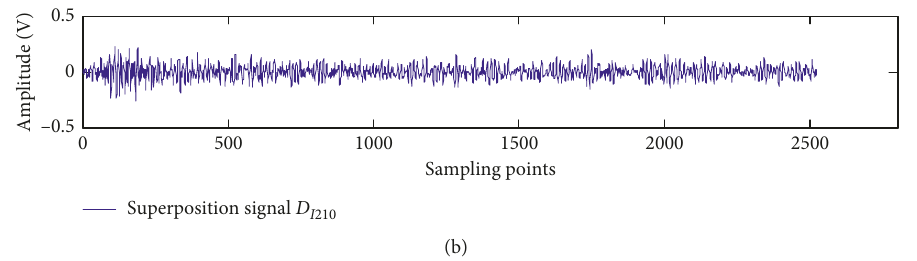
Figure 21: Two superimposed sections of the connecting rod bearing faulty signal. D